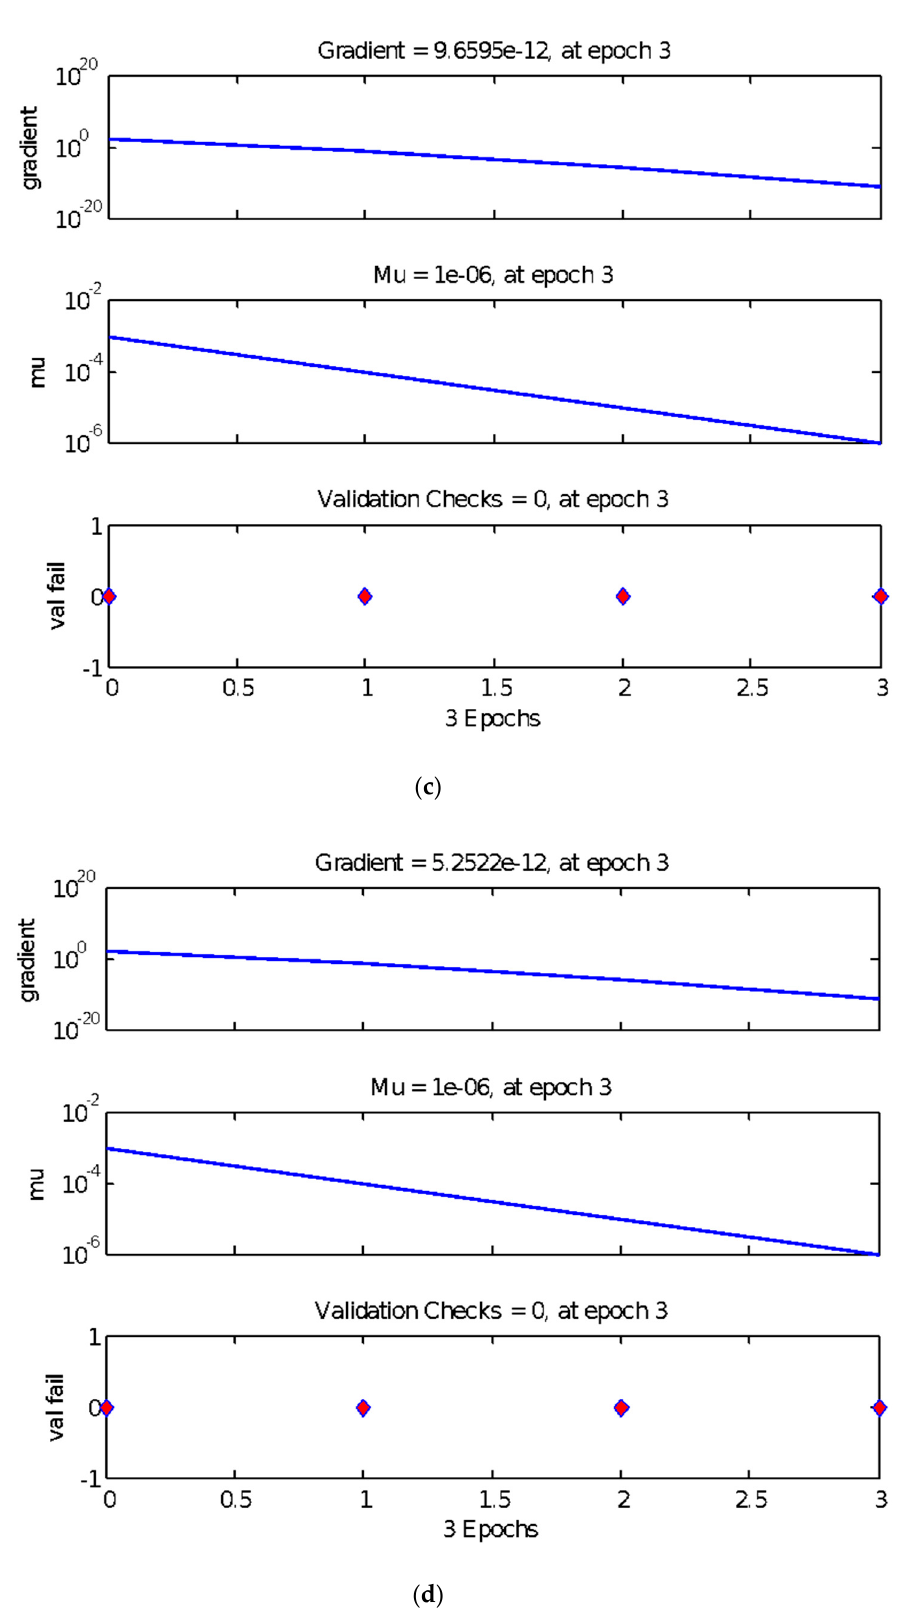
Figure 5. The relationship between gradient and learning times. ( a ) P-4c-k; ( b ) P-7c-k; ( c ) P-10c-k; ( d ) P-13c-k.